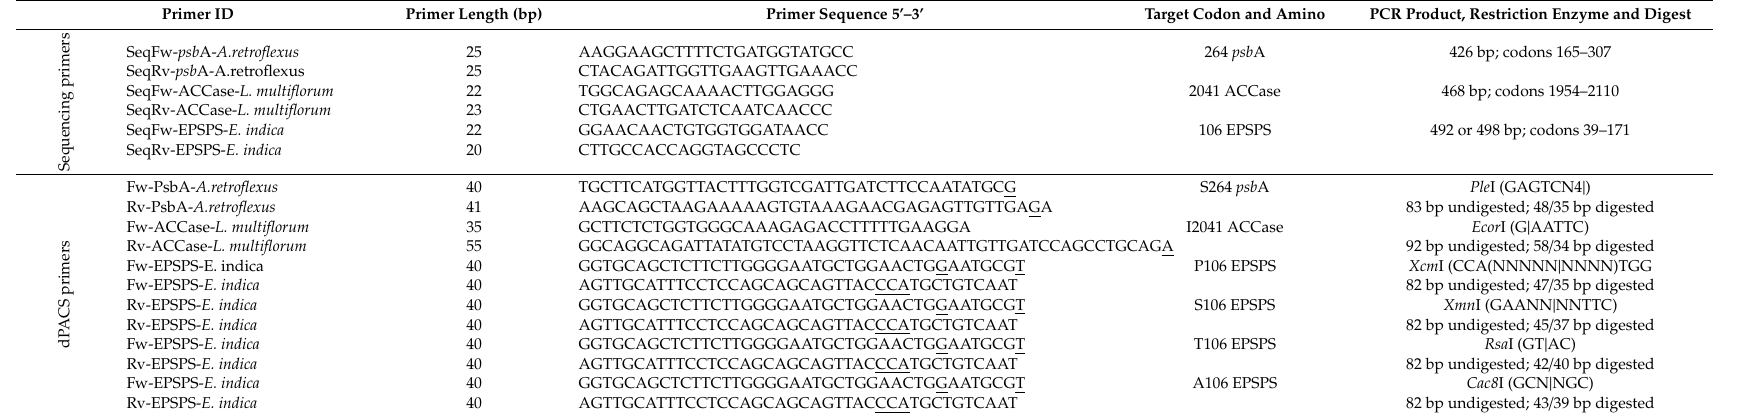
Table 3. Sequencing and dPACS primers employed and corresponding PCR products and restriction digests. The forced nucleotide mismatches on the primers are in bold and